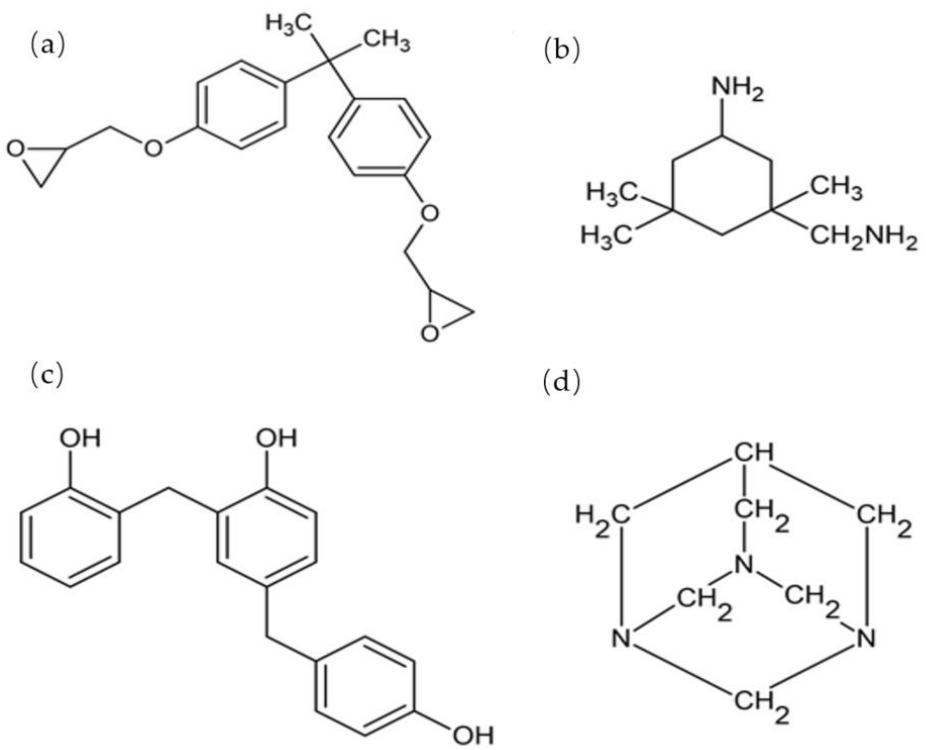
Figure 1. ( a )EpoxyD.E.R*331[22],( b )Jointmine905-3S,( c )Bio-phenolic(PH-3507)[23],( d ) Hexamine [18]. Figure 4